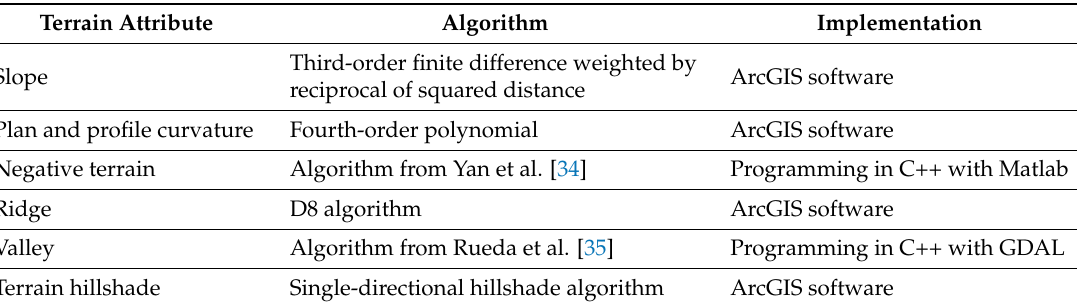
Table 2. Information of the calculation of terrain